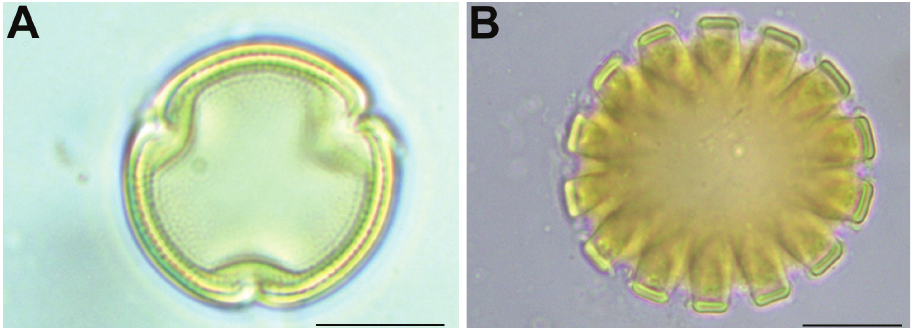
Figure 5. The two most abundant pollen types found in the food provisions of Mourecotelles braziliensis A Fabaceae sp.1 B Polygalaceae sp.1. Scale bars: 10 µm ( A ); 20 µm ( B